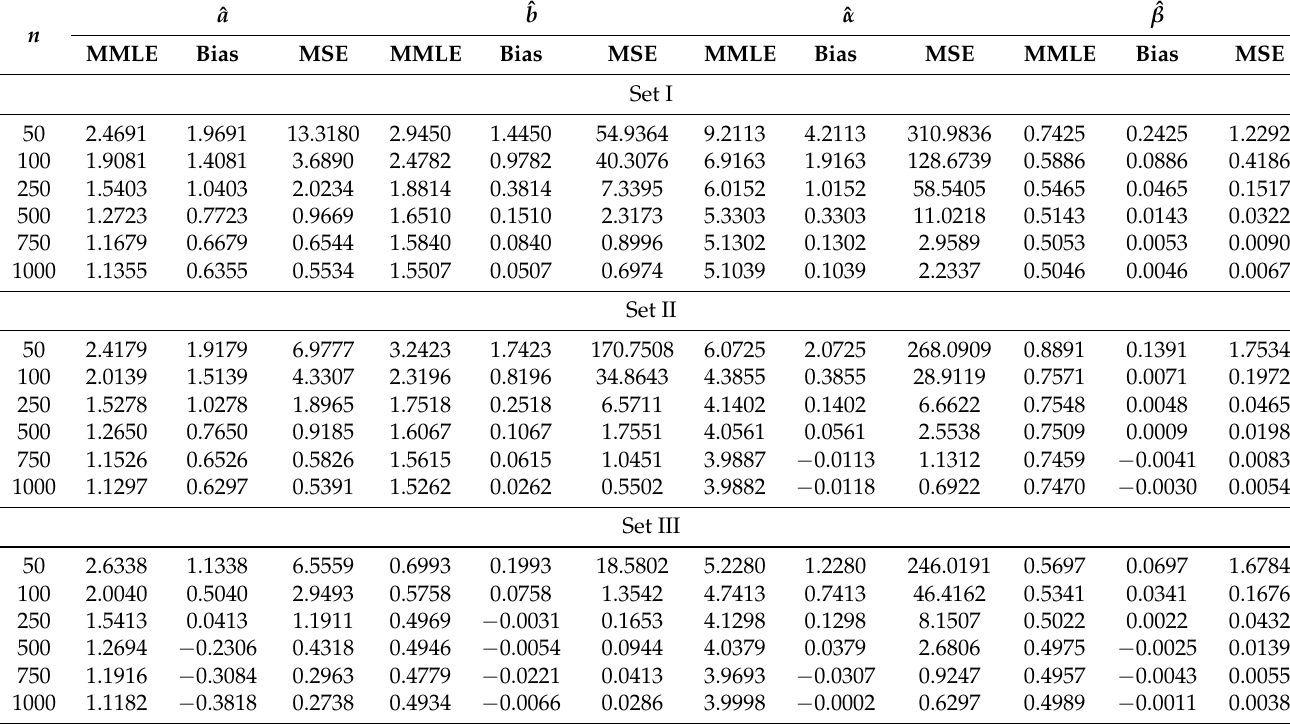
Table 1. Simulation results related to the MLEs of the NHLx model